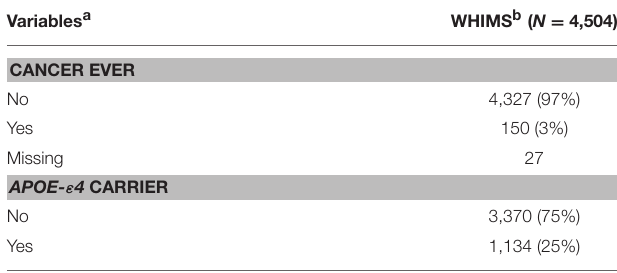
TABLE 1 | Demographic characteristics and health and cognitive profiles at baseline.